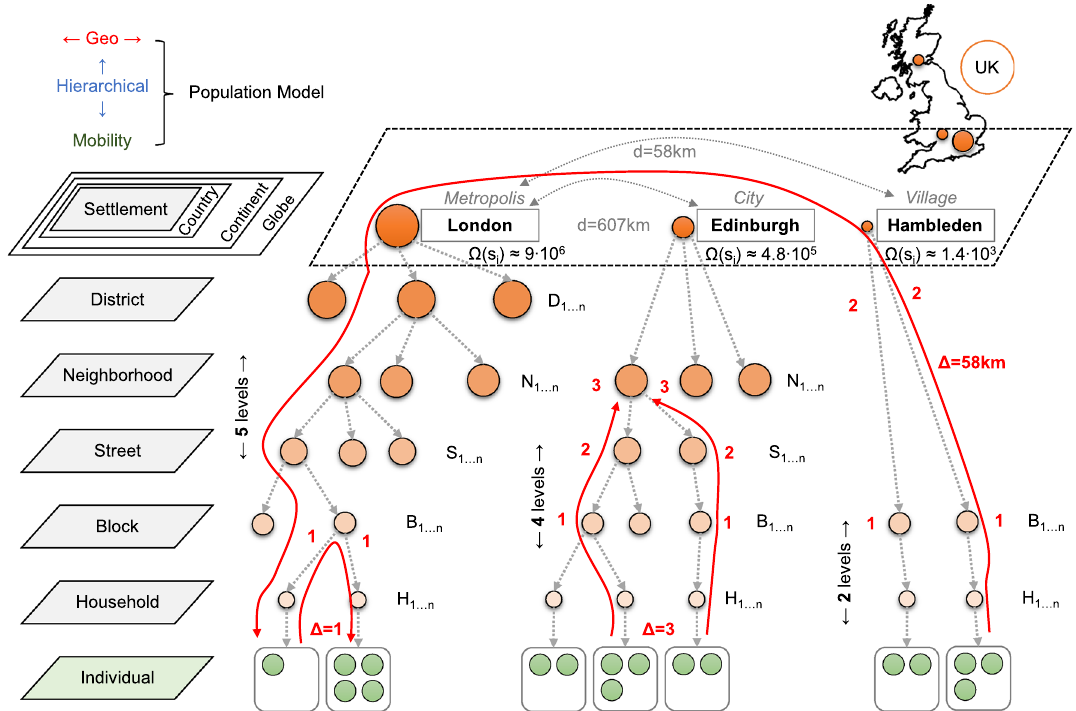
Figure 2. Conceptual representation of the hierarchical population structure of three settlements in the UK with real-world position and population. On the left side, all possible administrative divisions are enumerated; in the central panel, the hierarchical levels of each settlement are defined (orange nodes, based on the population �( s i ) ), down to the level of households which contain a small, random number (see “Methods”) of individuals (green nodes). The red arrows suggest three different mobility scenarios: (London) nodes move from one household to another with travel distance (cid:31) = 1 ; (Edinburgh) nodes moves from a household to the neighborhood level with travel distance (cid:31) = 3 ; (Hambleden) nodes move from one household to a random household in London, with travel distance (cid:31) = 58